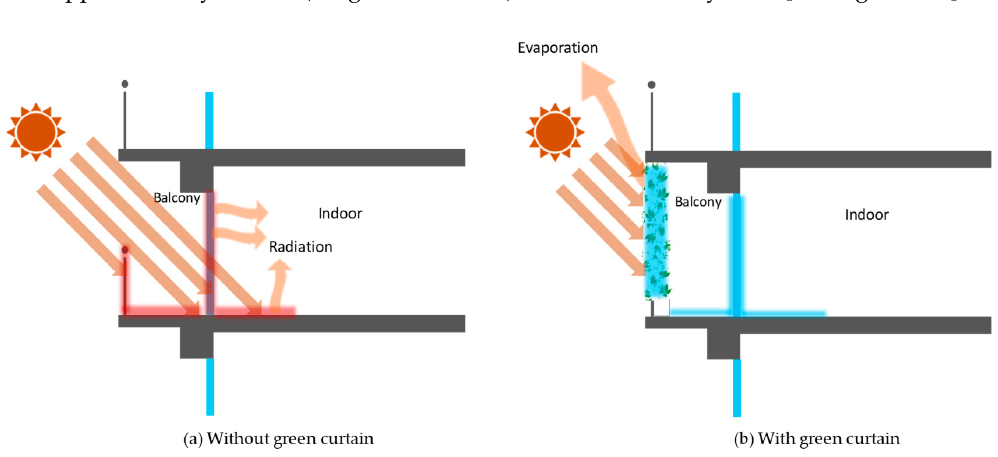
Figure 9. Section of balcony and indoor ( a ) with green curtain and ( b ) without green curtain. Table 3. Details of the instrument for environmental measurement.